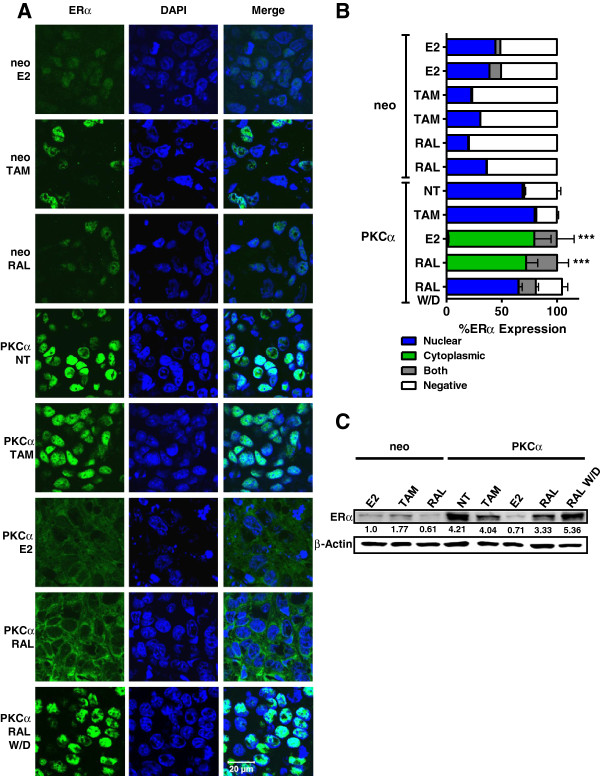
ERα localizes to extranuclear sites in E2- and RAL-induced T47D:A18/PKCα regressing tumors. A. Tissue sections were immunostained as described in materials and methods. Images are representative photographs of immunostained tumor sections. Sections were costained for ERα (green) and nuclei (blue). Scale bar = 20 μm. All images were acquired and processed using parameters described in materials and methods. PKCα, T47D:A18/PKCα; neo, T47D:A18/neo. B. Quantification of ERα localization in tumor sections. At least three fields from each tumor were counted. T47D:A18/neo is represented by two individual tumors. Bars representing T47D:A18/PKCα tumors show the mean (± SEM) of three individual tumors. ***, P < 0.001 compared to PKCα NT, TAM and RAL W/D by two-way ANOVA. C. Expression of ERα in whole cell tumor lysates. Molecular weights of ERα and β-actin are 67 kDa and 42 kDa, respectively. Values represent β-actin-normalized ERα expression relative to T47D:A18/neo E2-treated tumors.